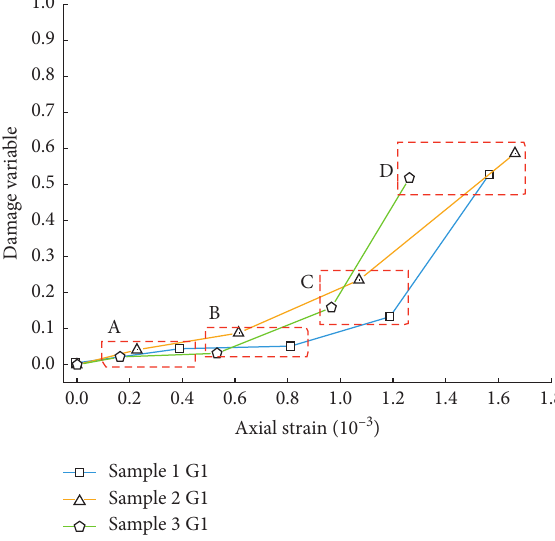
Figure 8: Damage evolution characteristic curve of SLB of spec- imens S 1, S 2, and S